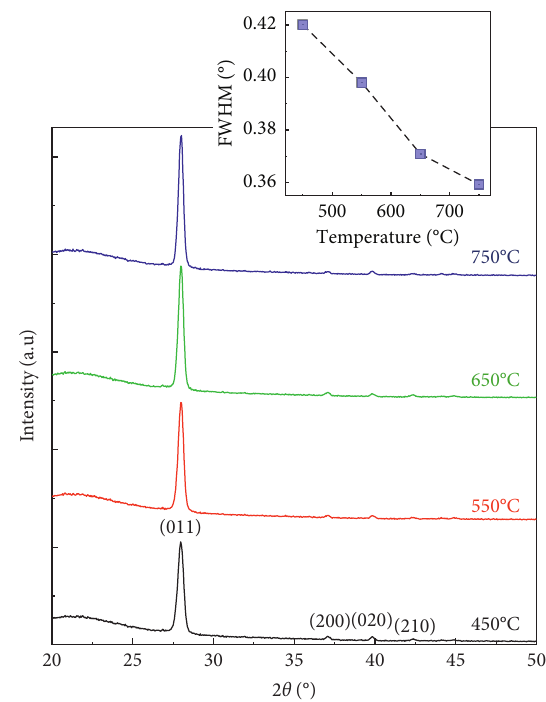
Figure 2: XRD patterns of the PLD VO 2 (M) films grown at dif- ferent temperatures. The inset shows the full width at half maxi- mum (FWHM) of the peak (011) versus growth